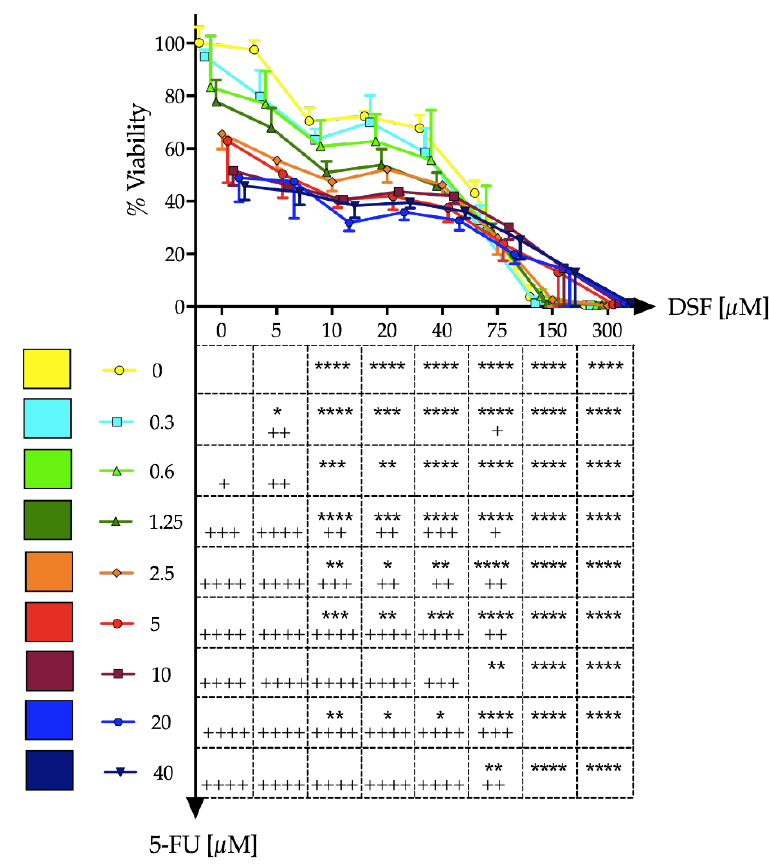
Figure 9. The combined effect of DSF and 5-FU on cell viability of Ca-Ski cells depicted using a Karnaugh color map.